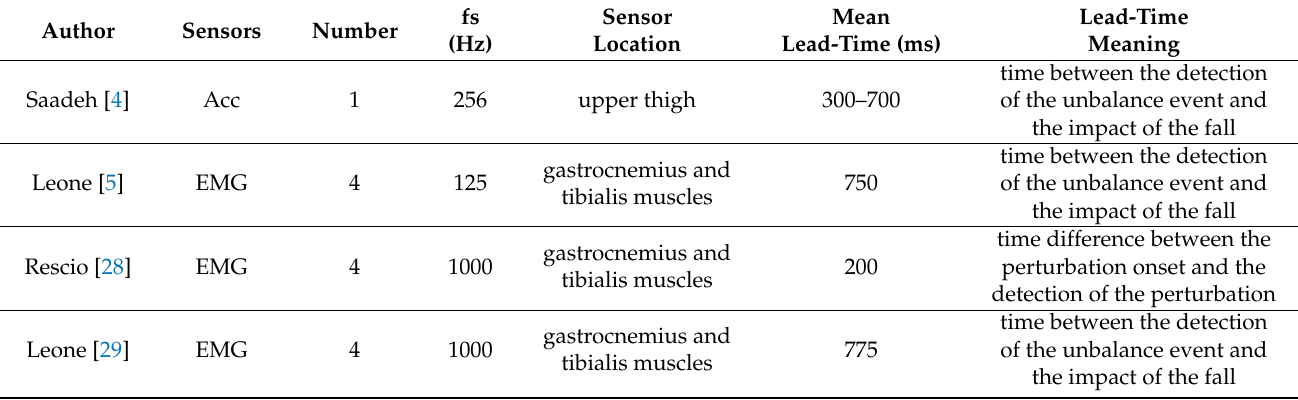
Table 1. Sensor characteristics from the fall risk assessment studies based on the detection of fall risk events, where: fs = sampling frequency, Acc =